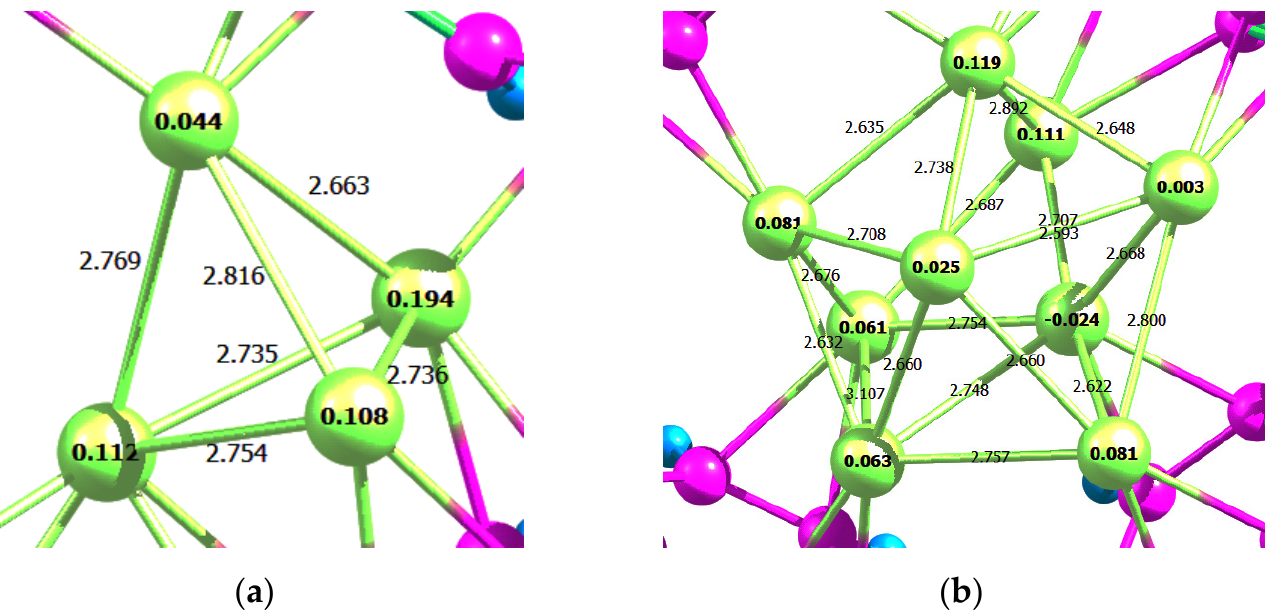
Figure 6. Löwdin charges and bond lengths for optimized polymer-stabilized Pd 4 ( a ) and Pd 9 ( b ).